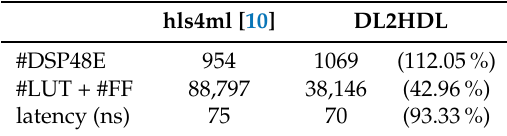
Table 7. Comparison with hls4ml framework, with percentage difference to original experiment [10].